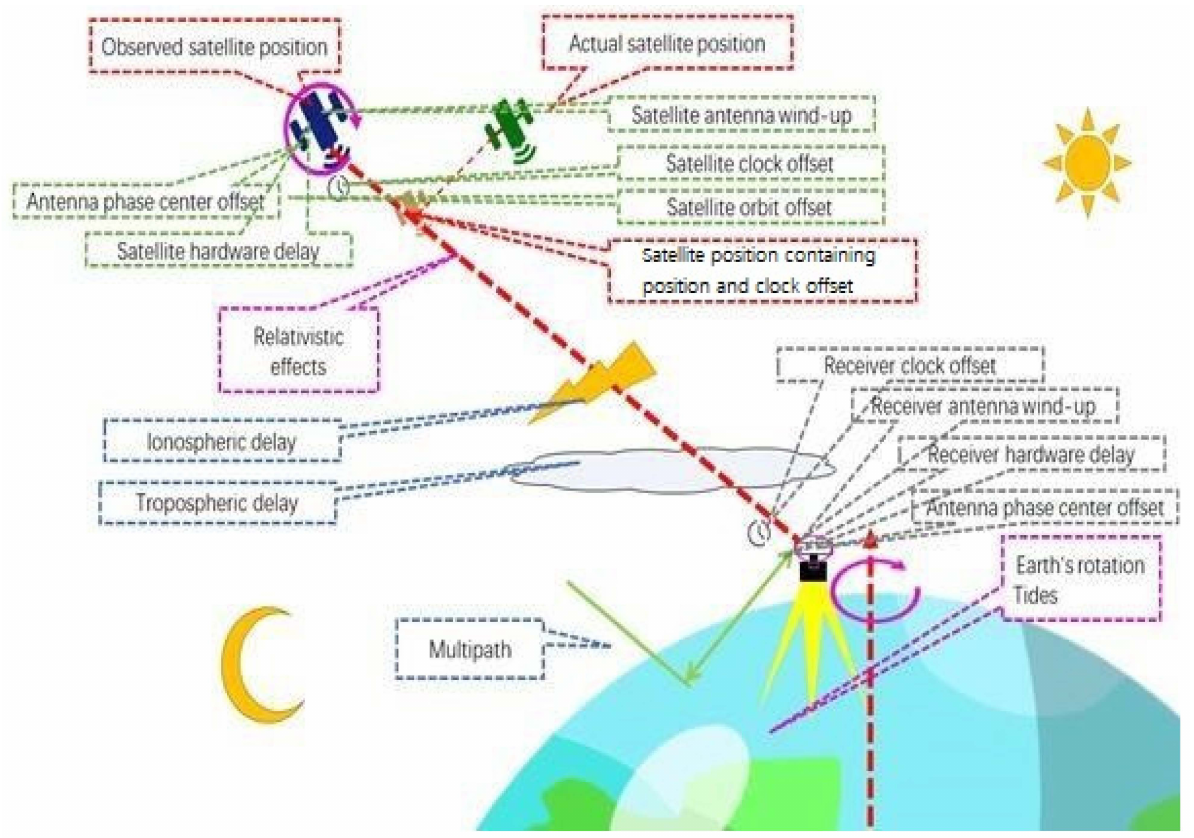
Figure 1. GNSS error